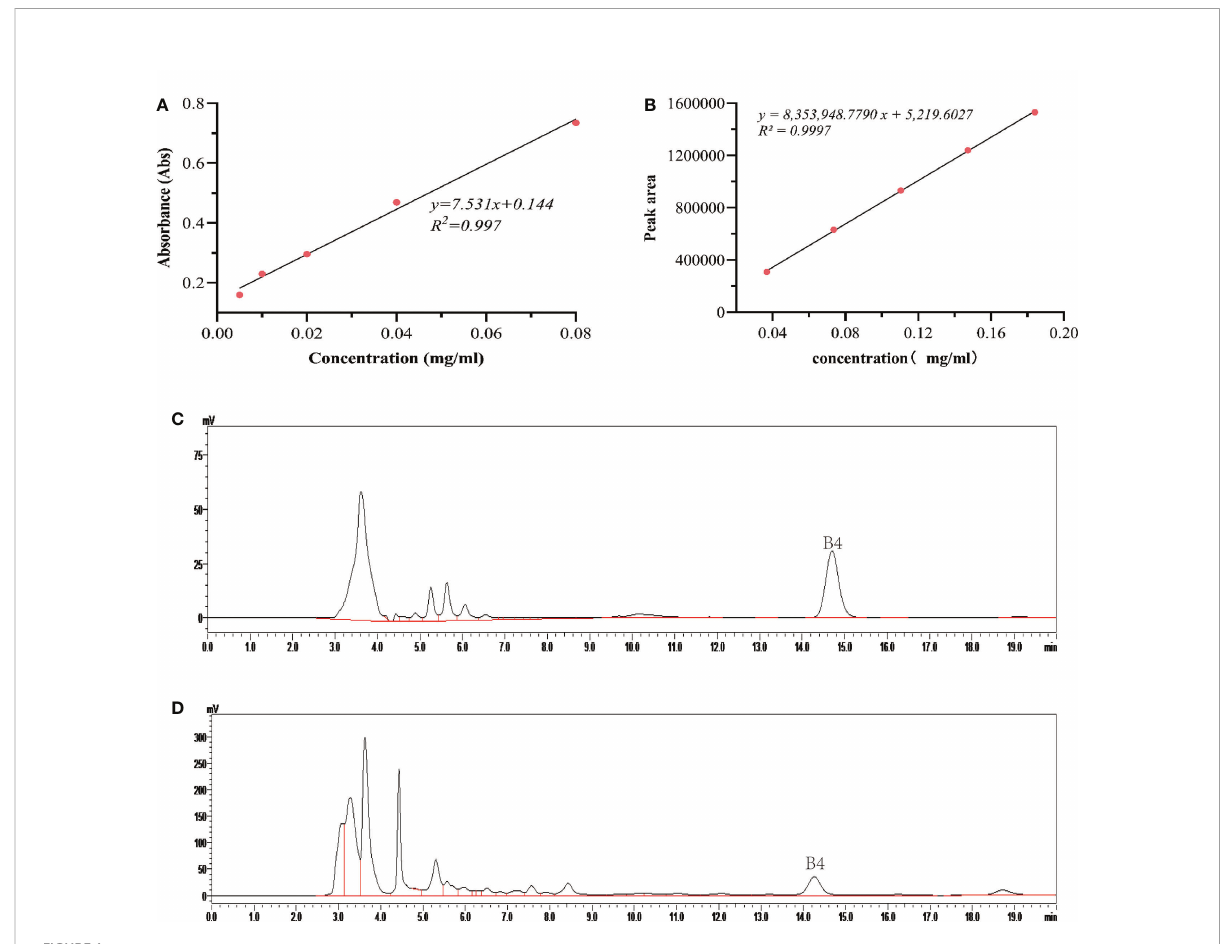
FIGURE 1 Effects of salicylic acid on carbon source consumption and saponin B4 accumulation in callus. (A) Standard curve of glucose; (B) Standard curve of Pulsatilla saponin B4; (C) High performance liquid chromatography (HPLC) of reference substance; (D) Sample